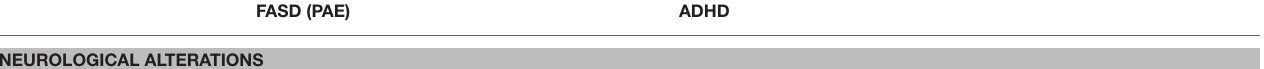
TABLE 1 | Main features shared that suggest a parallelism between ADHD (Attention deficit/hyperactivity disorder) and FASD (Fetal alcohol spectrum disorders). FASD (PAE)